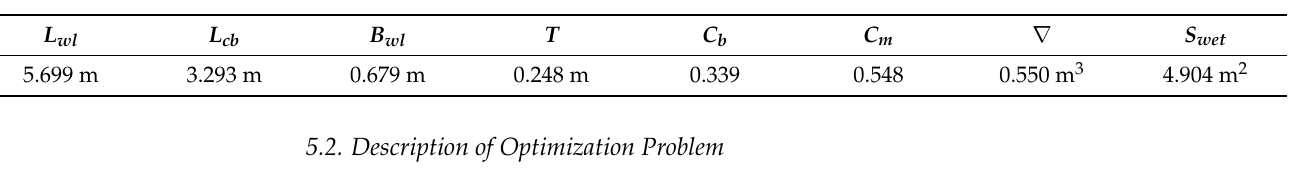
Table 4. Major parameters of DTMB 5415.